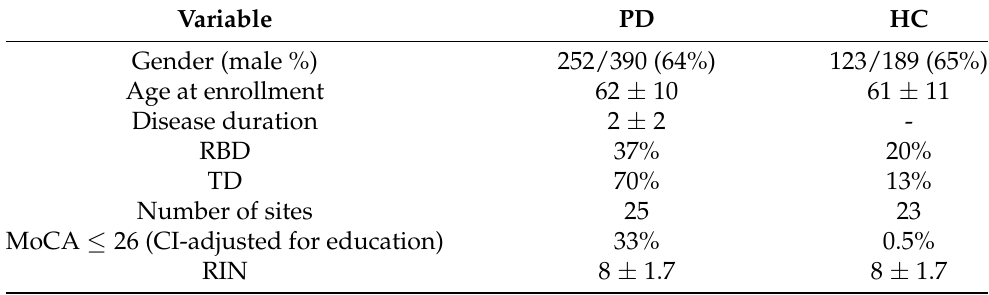
Table 1. Relevant clinical, pathological and technical metadata of the cohort divided by disease status.